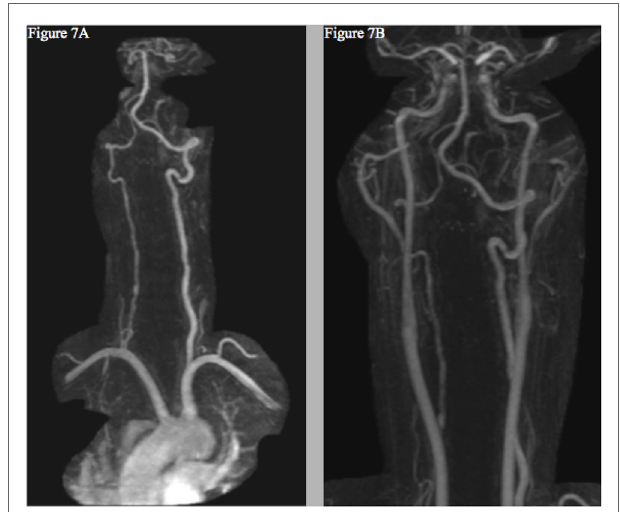
FIgURe 7 | Follow-up MRI angiogram showing interval improvement of the left vertebral (a) and internal carotid arteries (B) —without evidence of new dissection or aneurysm—and persistent right cervical vertebral artery contour irregularity (a) .